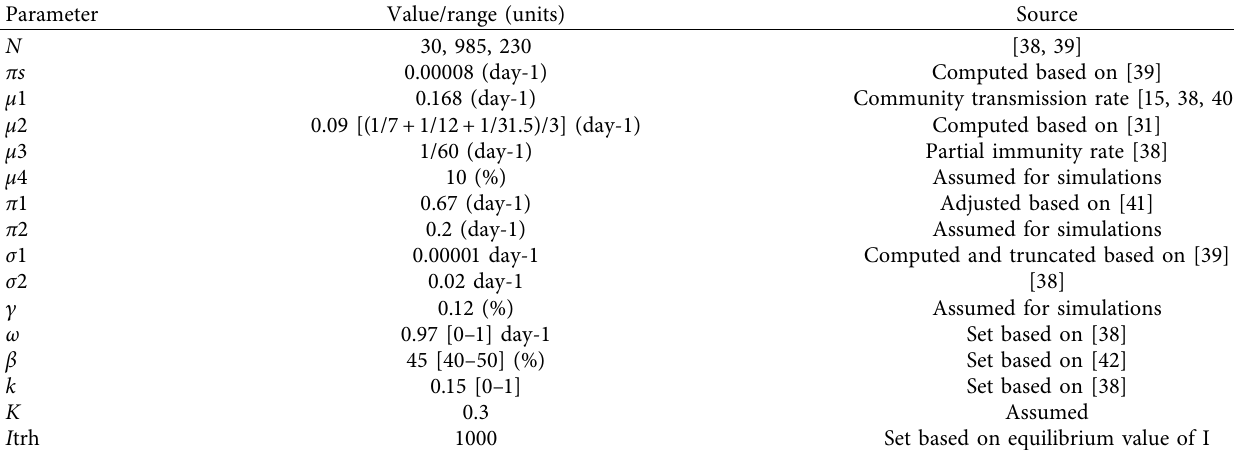
Table 3: Parameter estimates and sources.